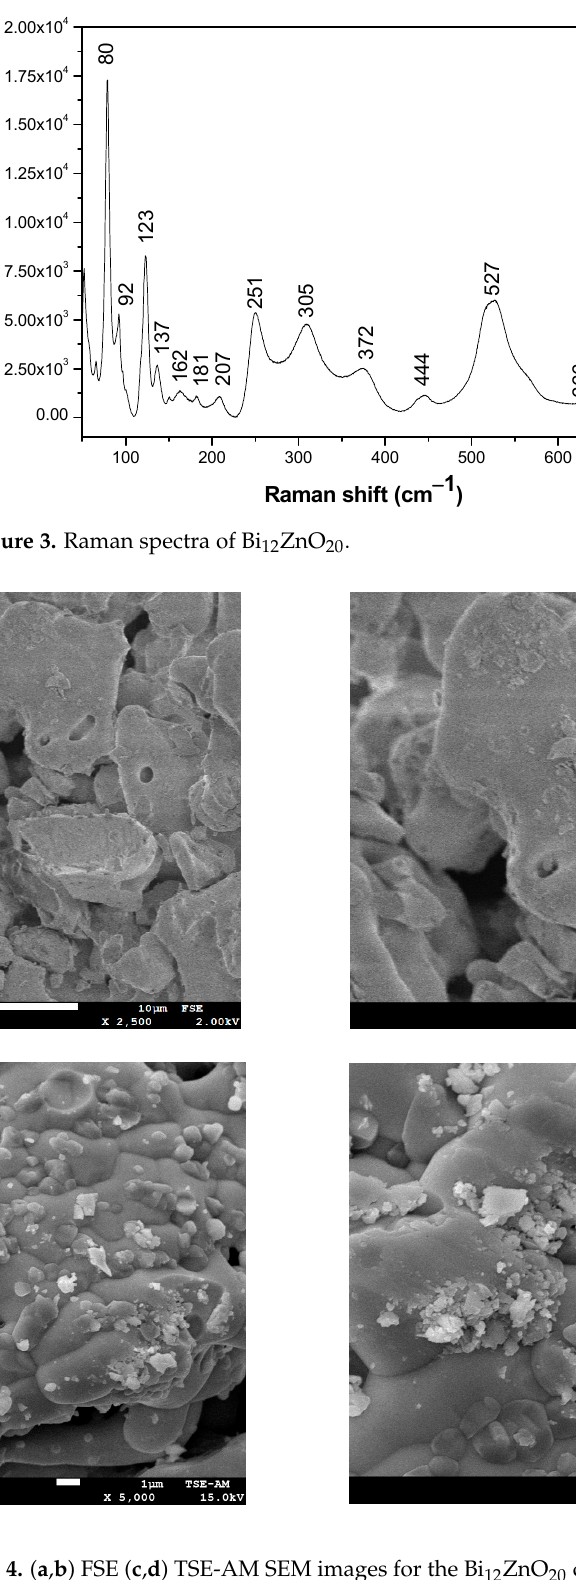
Figure 4. ( a , b ) FSE ( c , d ) TSE-AM SEM images for the Bi 12 ZnO 20